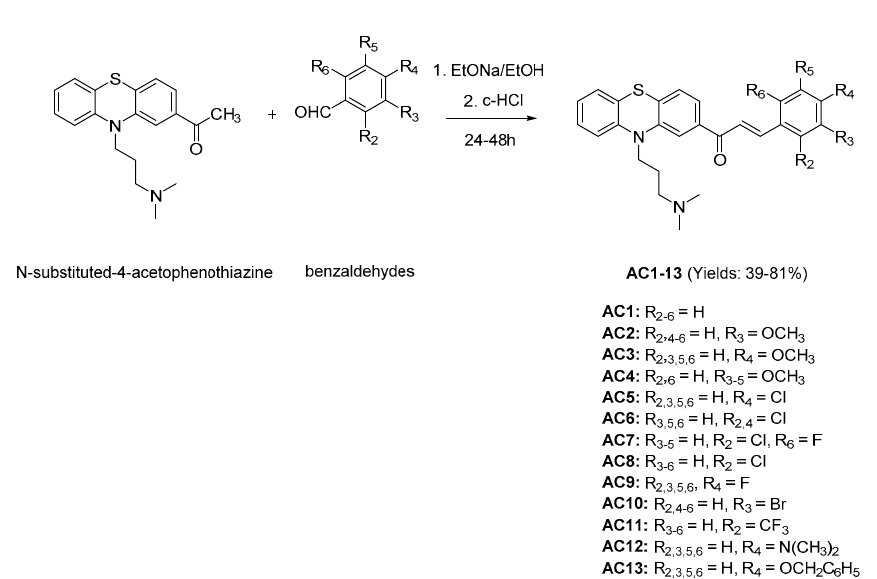
Figure 1. Claisen–Schmidt condensation reaction in chalcones synthesis. EtONa / EtOH: Sodium ethanolate in ethanol, c-HCl: concentrated hydrochloric acid.